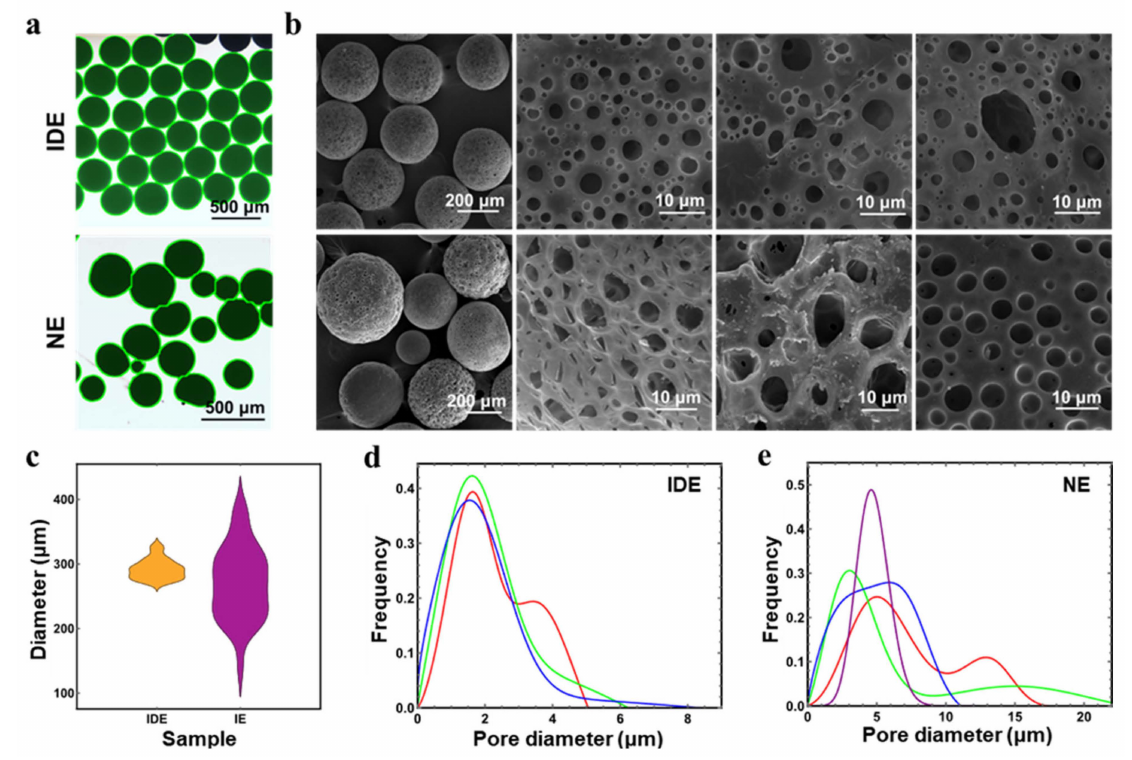
Figure 3. ( a ) Optical microscope photos of microspheres derived from IDE and NE; ( b ) SEM images of microspheres; ( c ) particle size distribution of the microspheres; ( d , e ) pore size distributions of microspheres derived from IDE and NE.